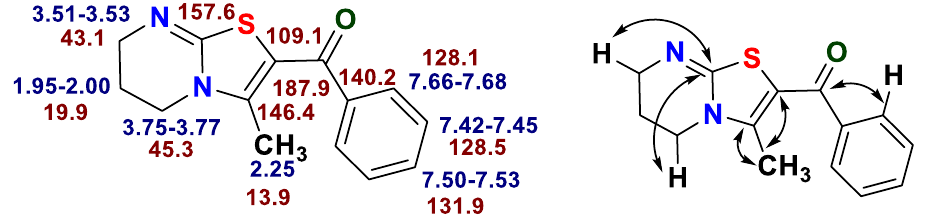
Figure 3. Showing 1 H-NMR (in blue) and 13 C-NMR (in brown) chemical shifts of compound 4a along with the correlation illustration.